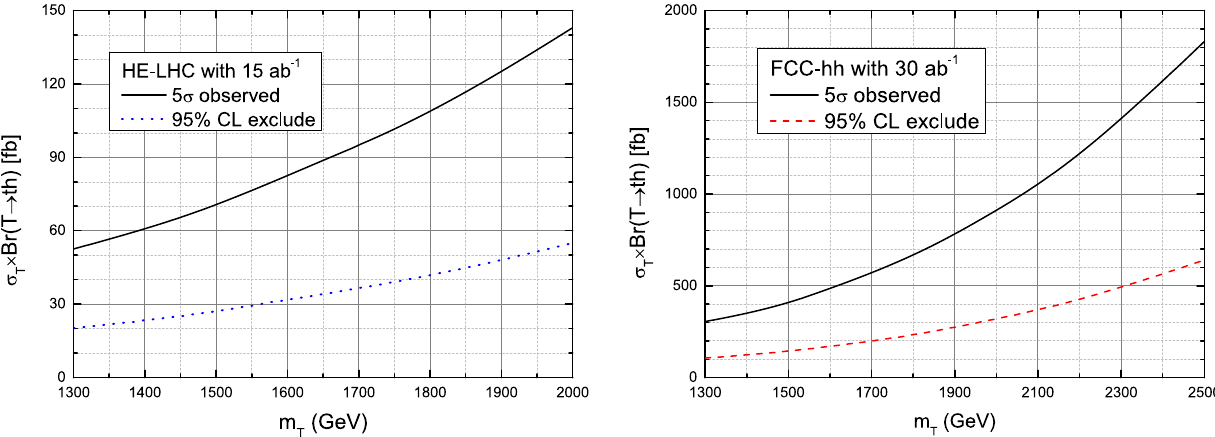
Fig. 5 The 95% CL excluded and 5 σ observed cross section times BR rates for the single- T signal as a function of the vectorlike top partner mass m T at the HE-LHC (left) and FCC-hh (right). Here we consider the systematic uncertainty as δ =